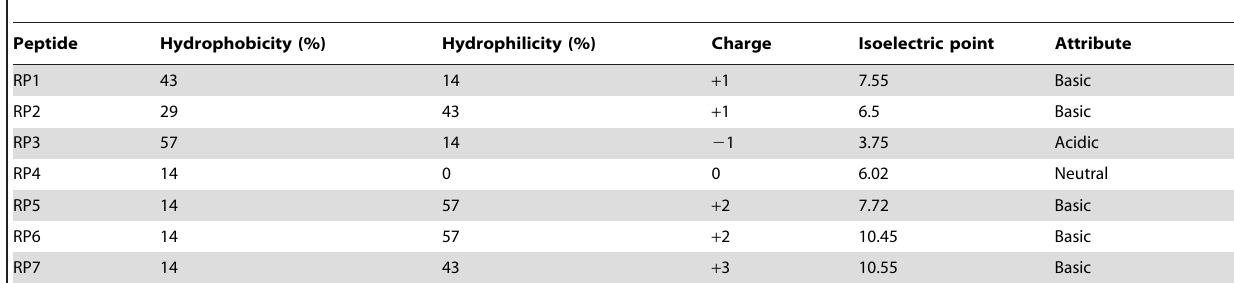
Table 2. Physical properties of recogniser